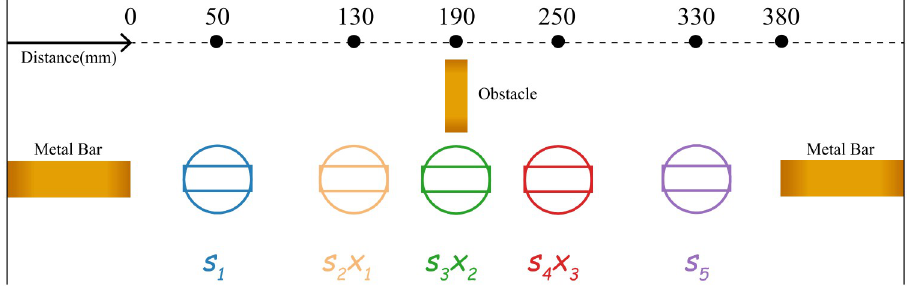
Fig 3. Drawing procedure. Two types of circuit shapes (i.e., line and circle) are selected to form the connection between two metal bars. The circle diameter and line length are both 100 mm . In total five shapes s 1 − s 5 are drawn sequentially on a 380 × 100 mm 2 workspace. The central coordinates of s 1 and s 5 are fixed. The central coordinates of s 2 − s 4 are denoted as x 1 − x 3 , which have a horizontal displacement range of ± 20 mm